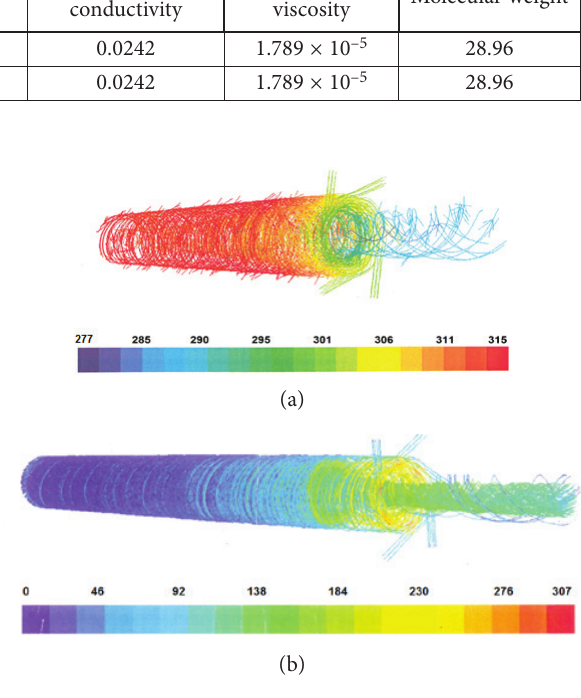
Figure 8. The distribution of (a) temperature and (b) velocity of the vortex tube at P in = 300 KPa